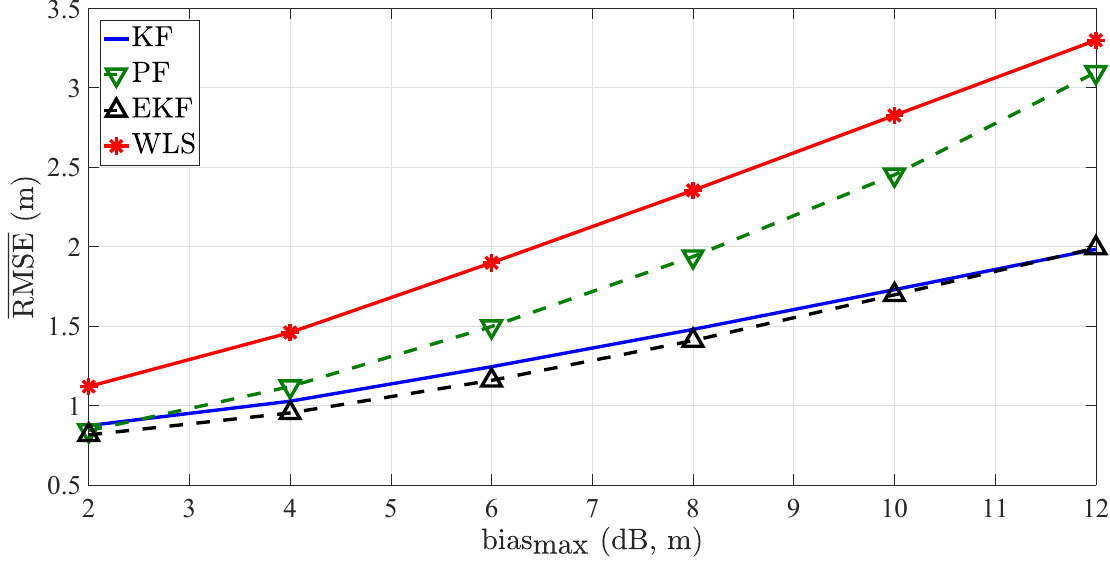
Figure 8. RMSE versus bias max (dB, m) comparison, when N = 4, |L NLOS | = 4, σ i = 1 (dB, m), bias i ∼ U [ 0,bias max ] , B = 30